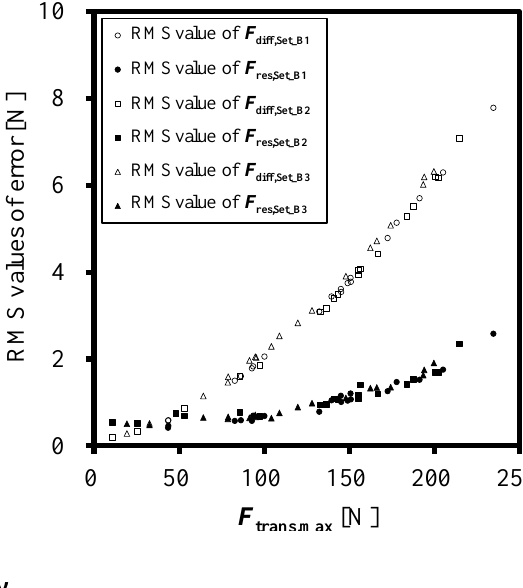
Figure 7. RMS values of F 20 sets of impact test with the three